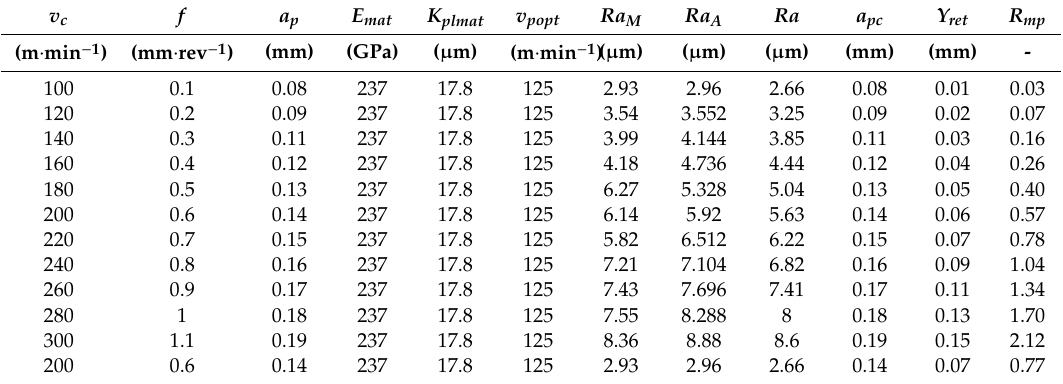
Table 8. Parameter estimates of the investigated dependence for the variable Ra .